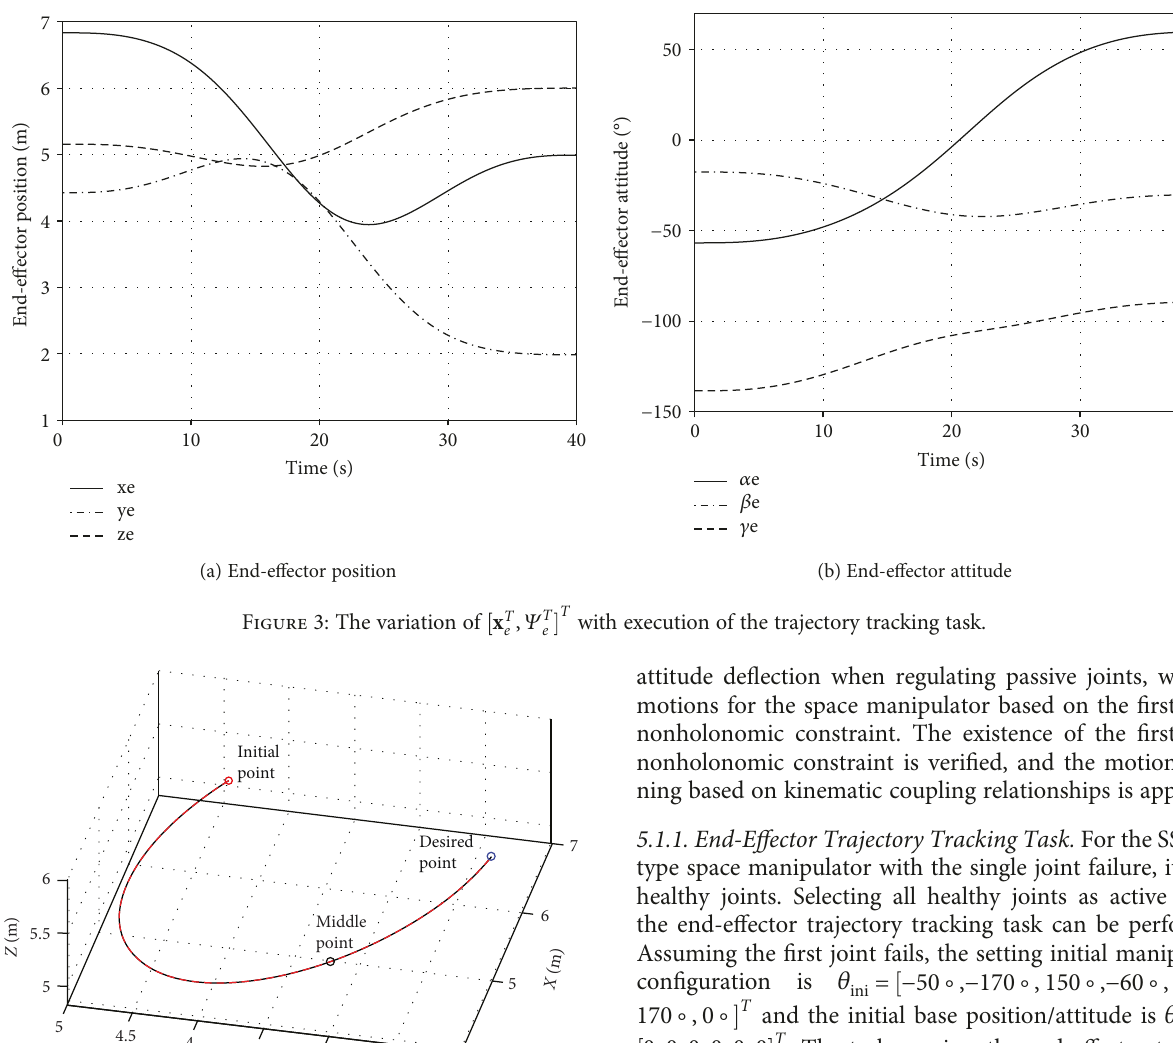
Figure 3: The variation of x T